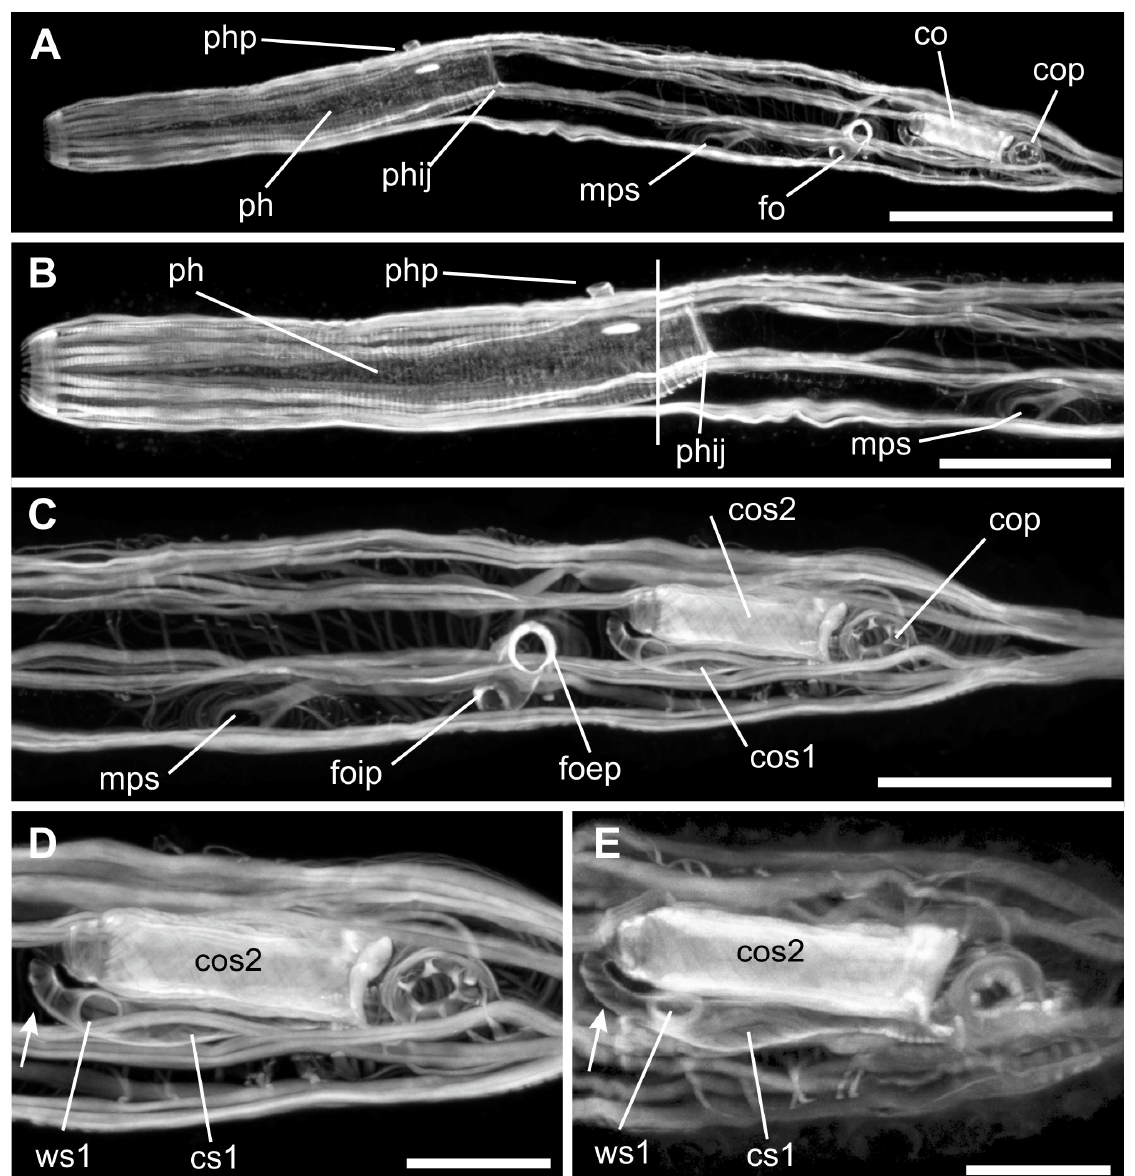
Figure 4. Photomicrographs of Urodasys bifidostylis sp. nov. (muscular system visualised with CLSM). ( A ) Whole adult specimen. ( B ) Close-up of the pharyngeal and mid trunk region. ( C ) Close-up of the mid- and posterior trunk region. ( D ) Details of the caudal organ, arrow indicates the connection between structure 1 and 2. ( E ) Details of the caudal organ of a different specimen; details of the caudal organ, arrow indicates the connection between structure 1 and 2. co—caudal organ, cop— caudal organ pore, cos1—caudal organ structure 1, cos2—caudal organ structure 2, cs1—chamber of structure 1, fo—frontal organ, mps—male pore sphincter, ph—pharynx, phij—pharyngo-intestinal junction, php—pharyngeal pore, ws1—window of structure 1. Scale bars: ( A ) = 100; ( B , C ) = 50 µm; ( D , E ) = 20 µm.